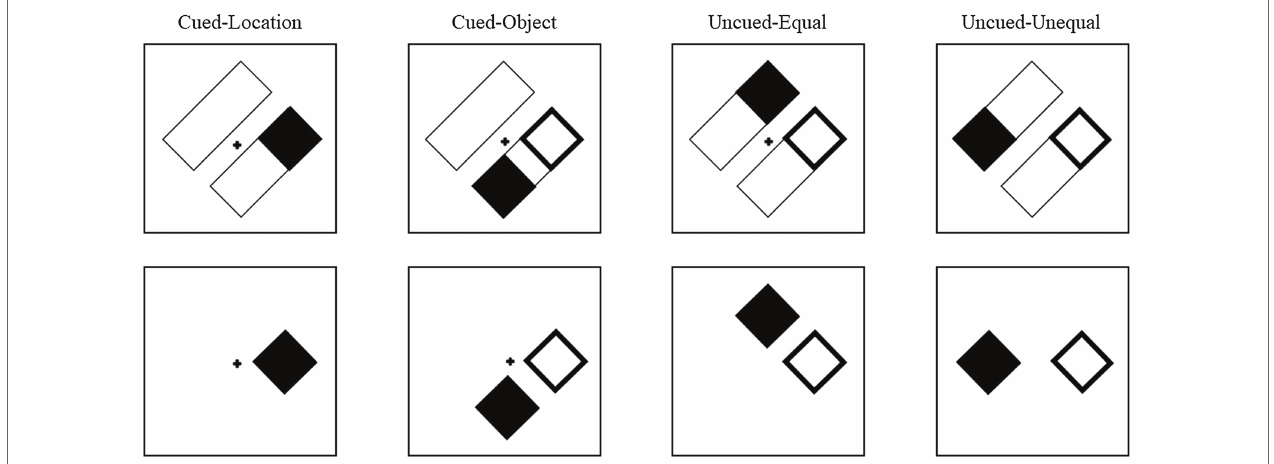
FIGURE 4 | Examples of cue-target conditions for Experiment 2. The conditions are labeled based on the target’s position relative to the cue. In the cued-location condition, the target (filled square) appeared at the same location that was cued (unfilled square). In the cued-object condition, the target was presented in the same rectangle as the cue, but at the opposite end. In the uncued-equal conditions, the target was presented in the uncued rectangle at a location equidistant from the cue as the cued-object condition. In the uncued-unequal condition, the target was presented at the other end of the uncued rectangle, diagonal from the cue. The same conditions were presented in the object-absent trials, but in the absence of the rectangles, thus there was no qualitative difference between cued-object trials and uncued-equal